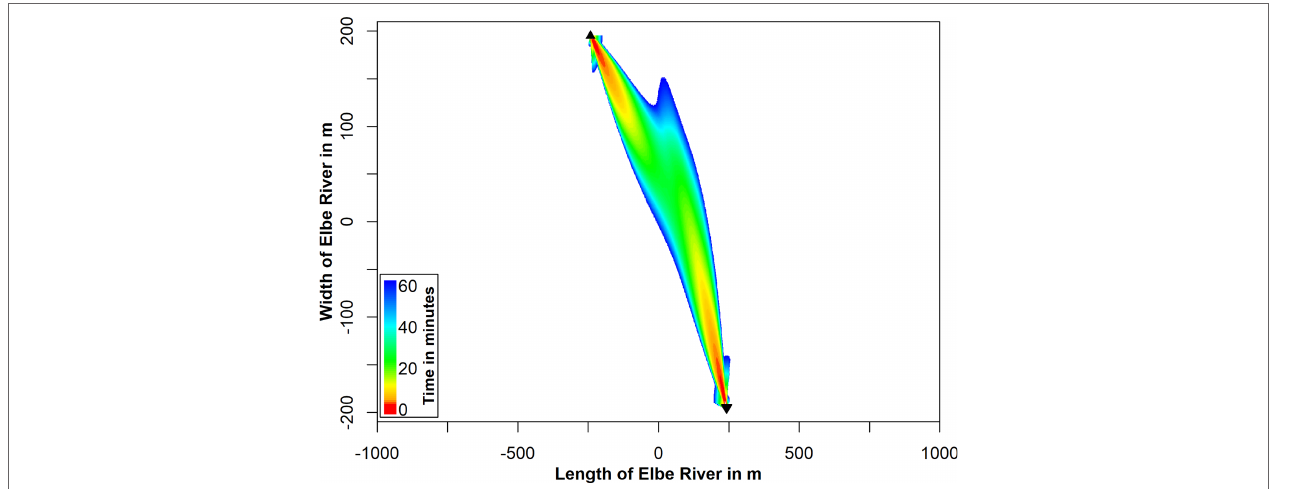
FIGURE 8 | The time in minutes is presented (color-coded), which is needed to exceed the cumulative SEL-TTS onset of 153.3 dB re 1 µPa²s. Only the areas, where a TTS can be induced within 60 minutes for an inter-pulse interval of 4.2 s are marked. The flowmeter positions are marked by black